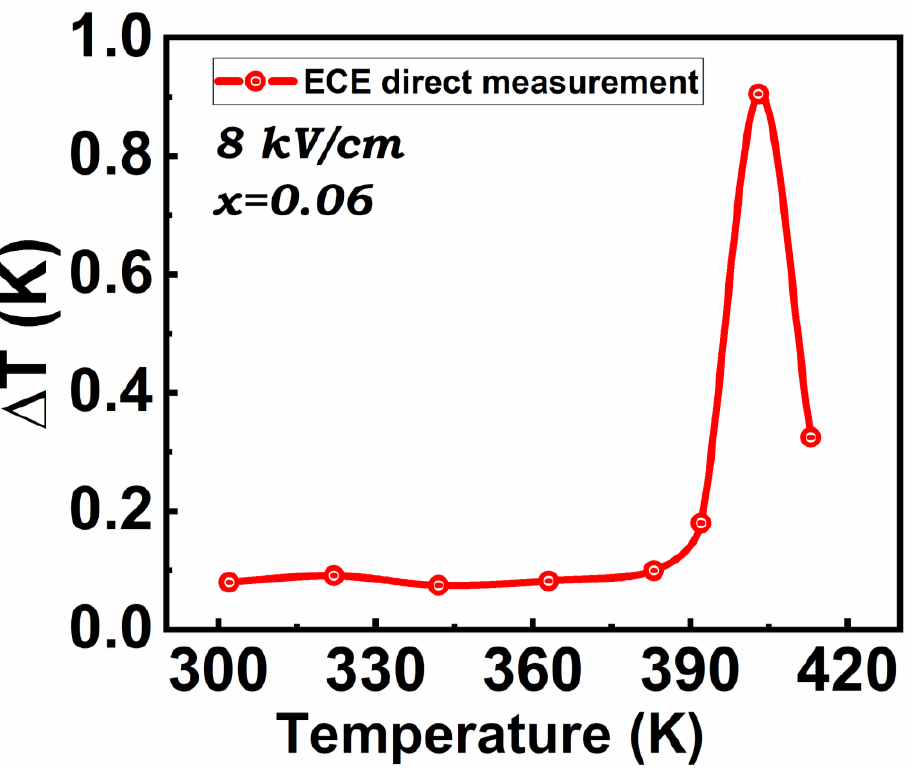
Figure 9. Adiabatic electrocaloric temperature variation obtained from composition BTG6 by the direct method under applied electric field of 8 kV/cm.